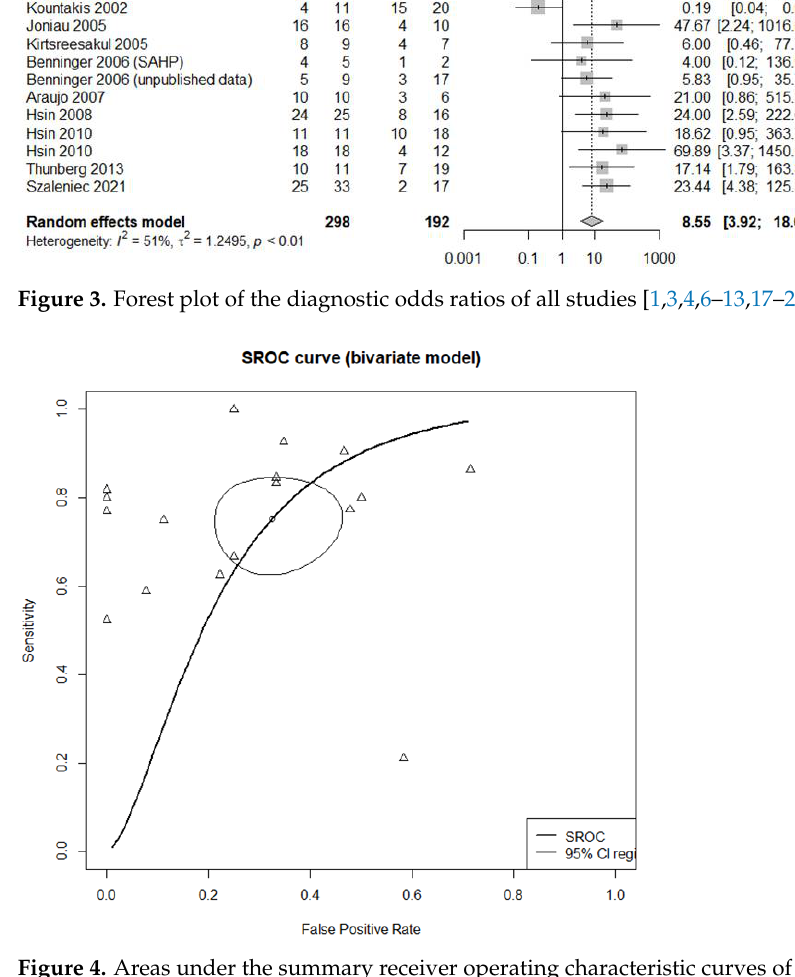
Figure 4. Areas under the summary receiver operating characteristic curves of all studies.